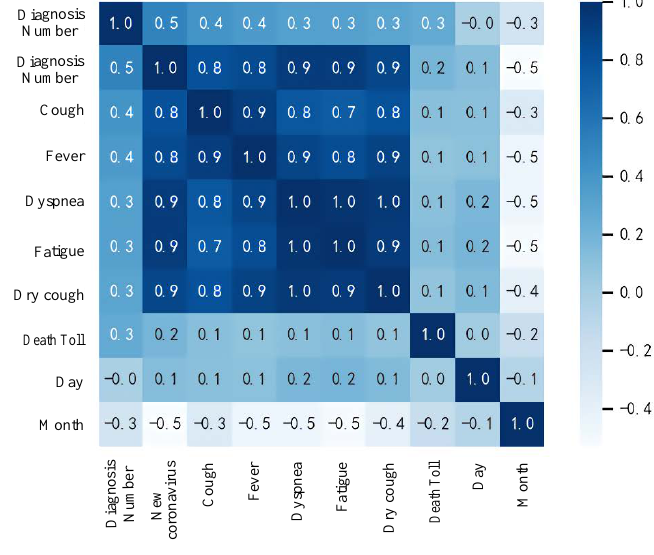
Figure 5. Heat map between